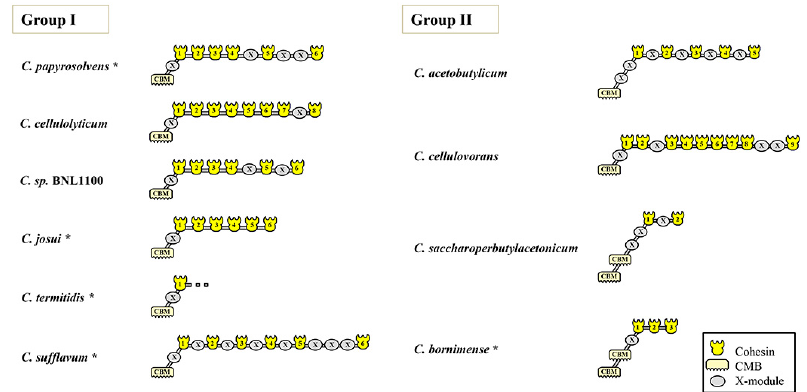
Figure 2. Modular and domain architectures of the primary scaffoldins of mesophilic